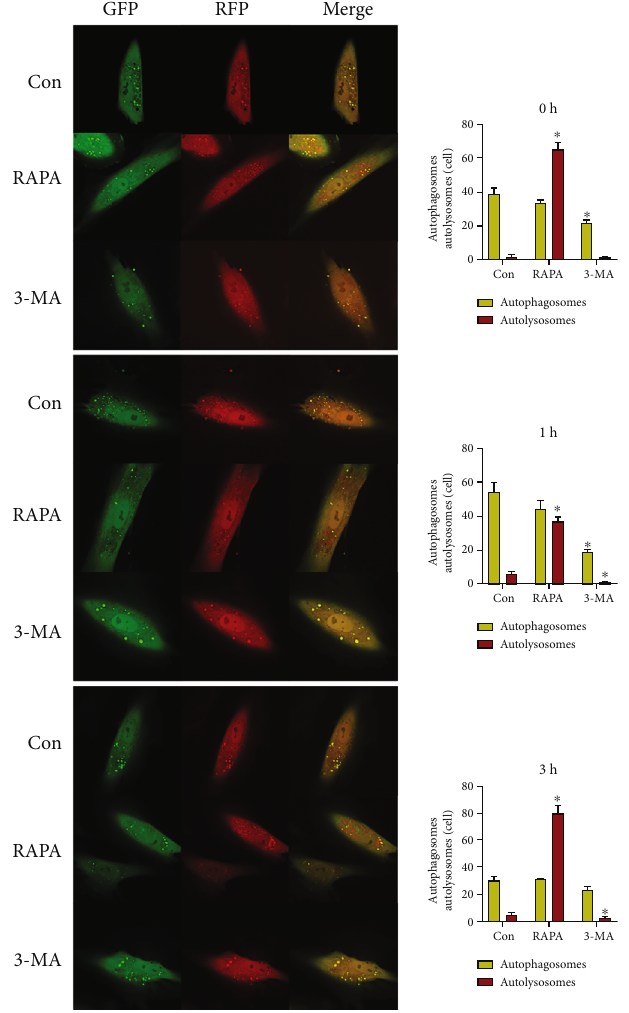
Figure 10: The detection of autophagy fl ux after drug regulation. ∗ P < 0 : 05 . GFP: green fl uorescent protein; RFP: red fl uorescent protein; RAPA: rapamycin; 3-MA: 3-methyladenine; Con: